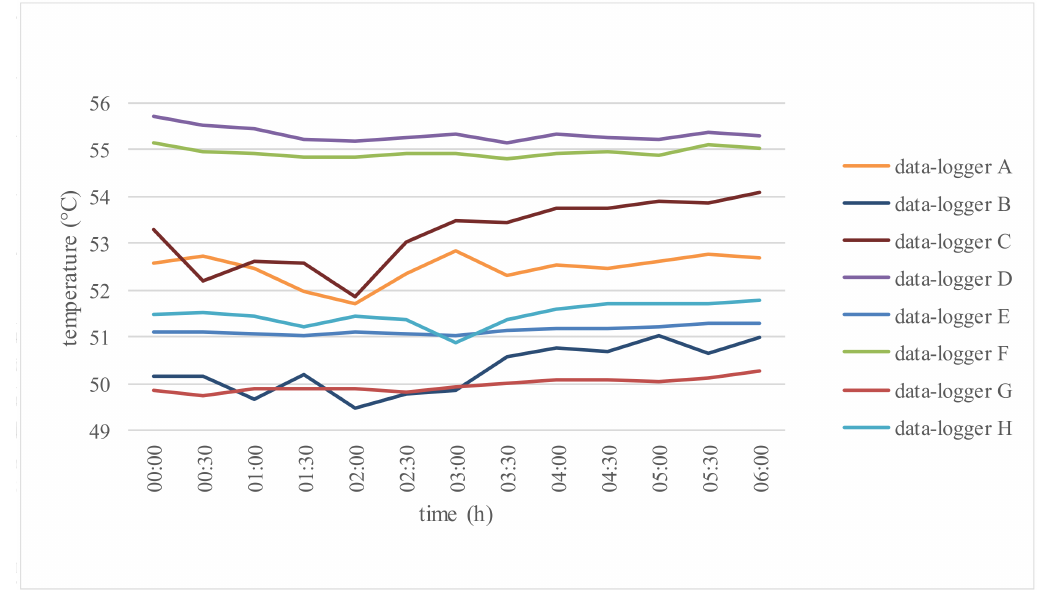
Figure 7. Air temperatures detected by the temperature probes from 12:00 a.m. to 6:00 a.m. on 26/04/2014.